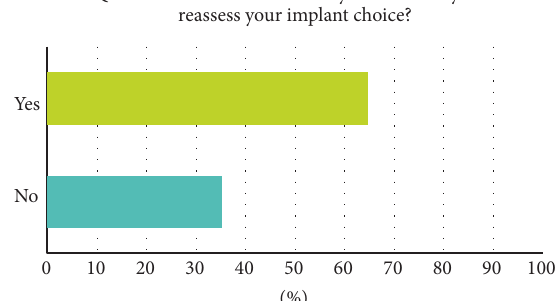
Figure 3: Example question taken from the survey, answers in per-